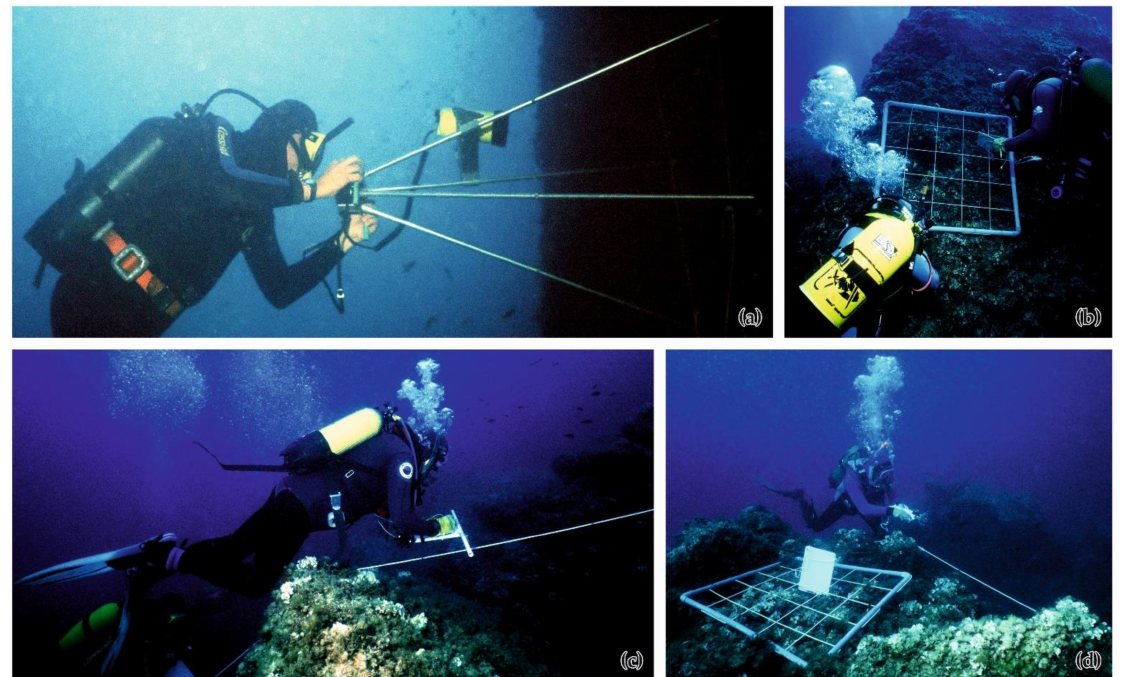
Figure 5. Examples of non-destructive techniques for biodiversity monitoring: ( a ) underwater photography; ( b ) quadrat; ( c ) transect; ( d ) quadrats and transects can be complementary, rather than alternative,